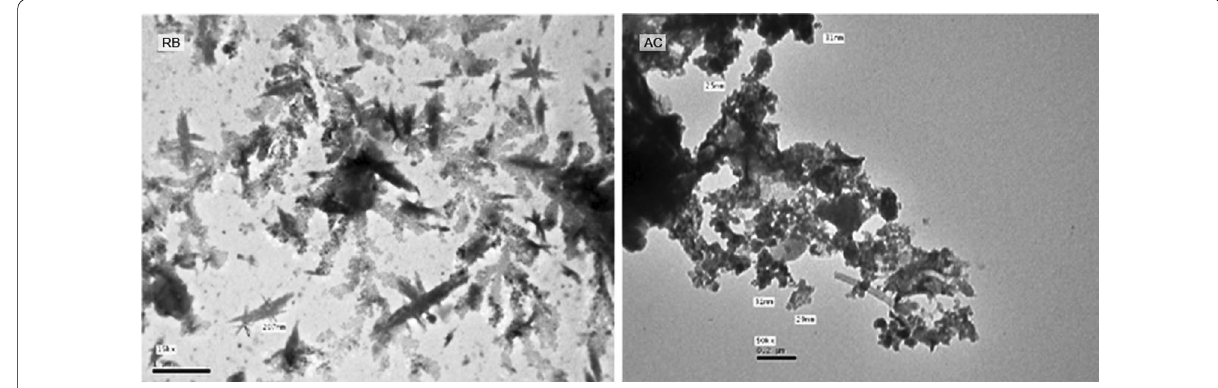
Fig. 5 TEM images of RB, and AC